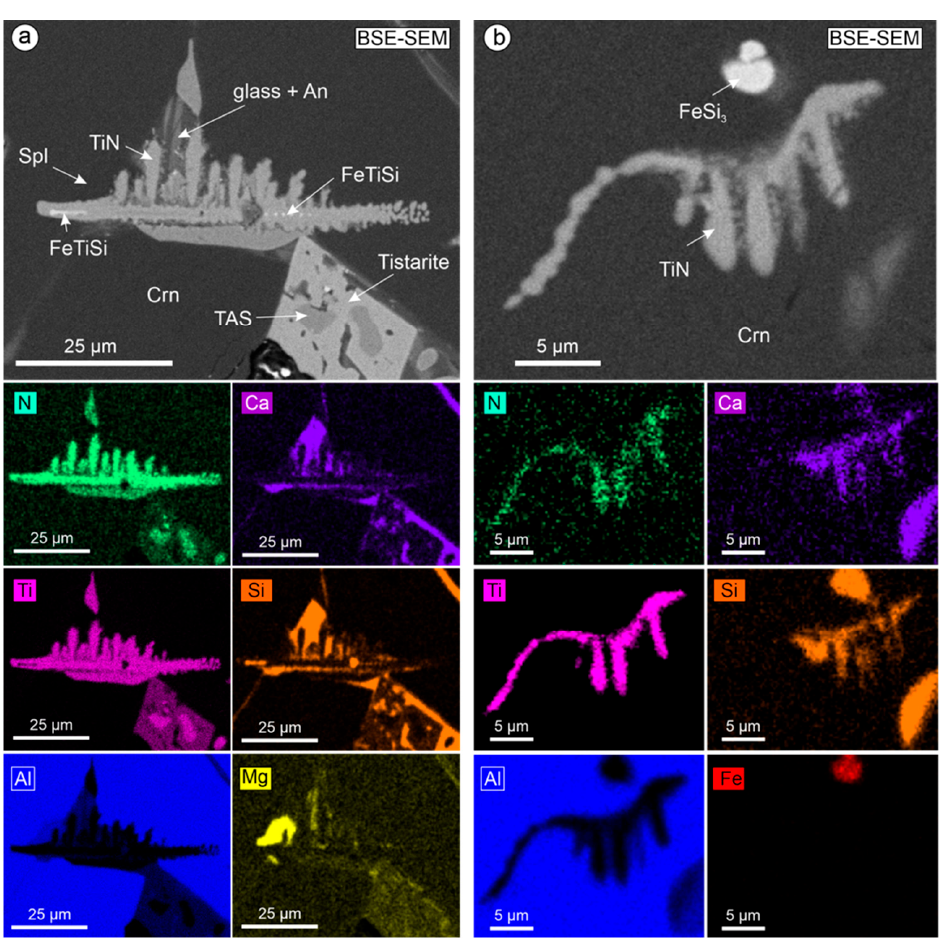
Figure 6. ( a ) BSE image and element maps of a branching Ti nitride lens with immiscible blebs of Fe silicide across the center. Note emulsion rims on vertical branches in contact with silicate glass, but not against tistarite. ( b ) BSE image and element maps of Ti nitride filling a branched interstitial space between dentate corundum crystals; each part of the Ti nitride structure is surrounded by silicate glass. Bright blob is FeSi 3 melt. Crn = corundum; Spl = spinel.